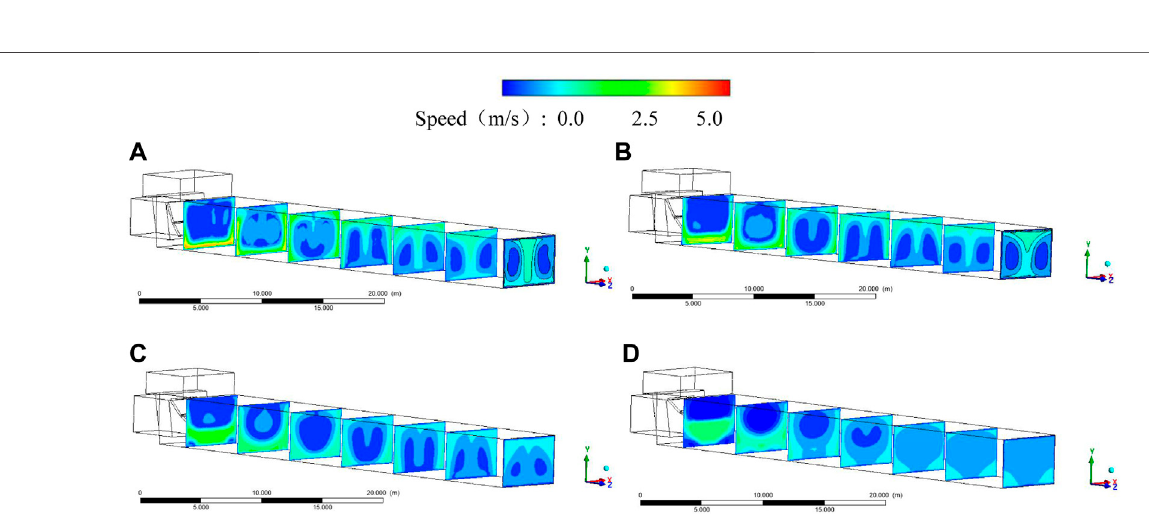
Frontiers in Energy Research |